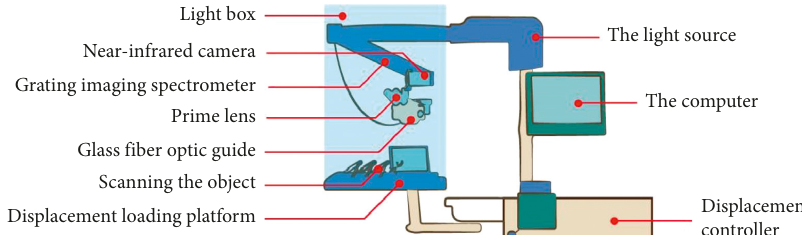
Figure 1: Hyperspectral image acquisition